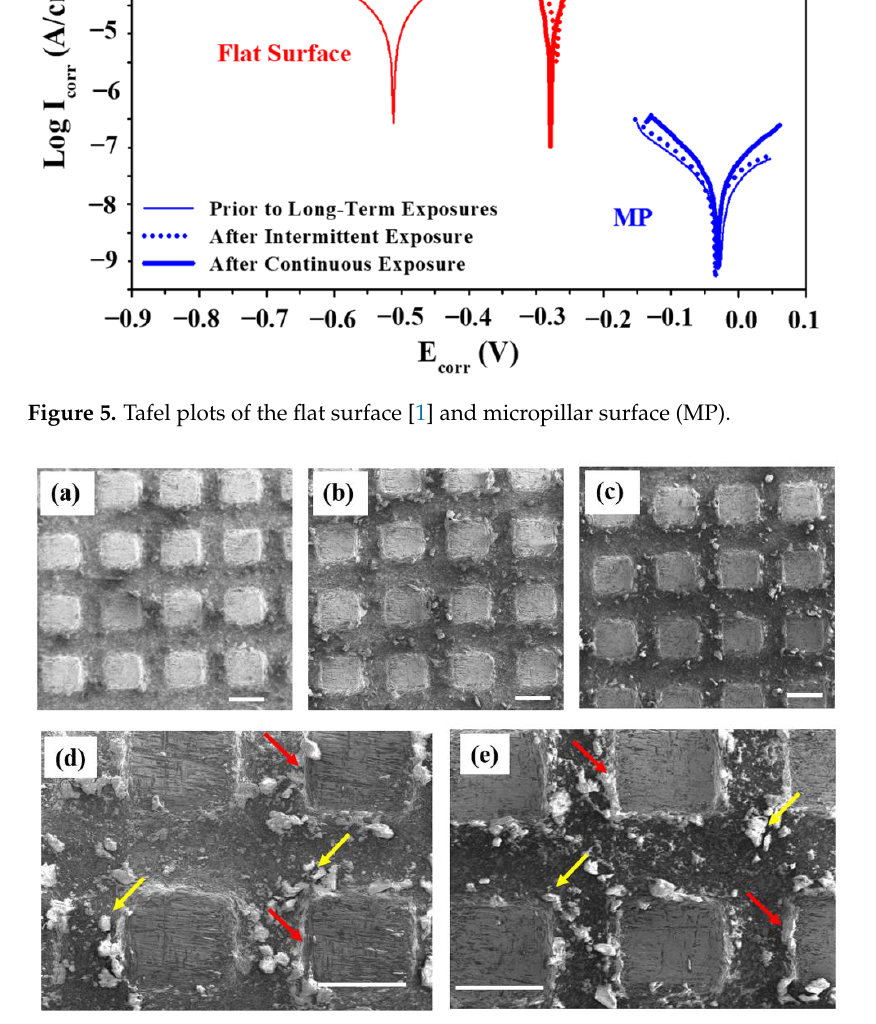
Figure 6. Scanning electron microscopic images of MP surfaces taken after corrosion tests: ( a ) before long-time exposure, ( b ) after intermittent exposure, and ( c ) after continuous exposure to NaCl solution. ( d , e ) are high magnification images of ( b , c ). Yellow arrows show corrosion products dislodged from the top region of micropillars. Red arrows show wetting of micropillars over their sides adjacent to the top. (Scale bar: 100 μ m).